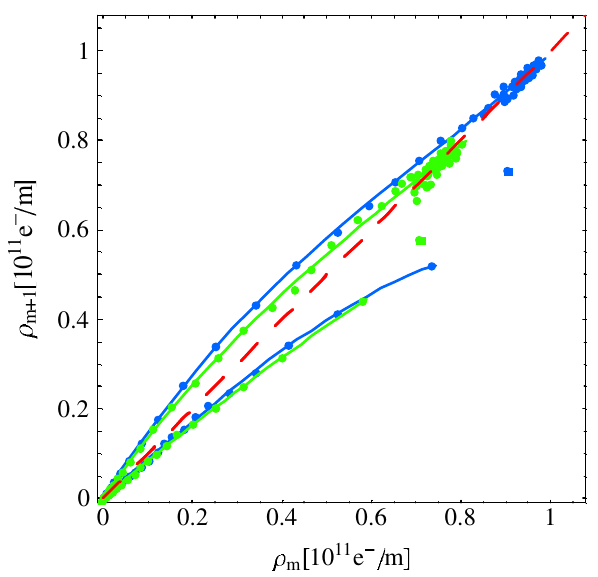
FIG. 2. (Color) Average e-cloud density map (cid:2) markers: ECLOUD simulations ( (cid:1) as in Table I). The dashed red line represents saturation ( (cid:2) (cid:2) ). Markers above the saturation line describe the e-cloud m buildup (cyan: N (cid:5) 1 : 6 (cid:3) 10 11 ; green: N (cid:5) 0 : 8 (cid:3) 10 11 ). Markers below the saturation line describe the e-cloud decay. The cyan and green lines are the corresponding cubic fits. Transitions between filled and empty bunch trains are shown as square